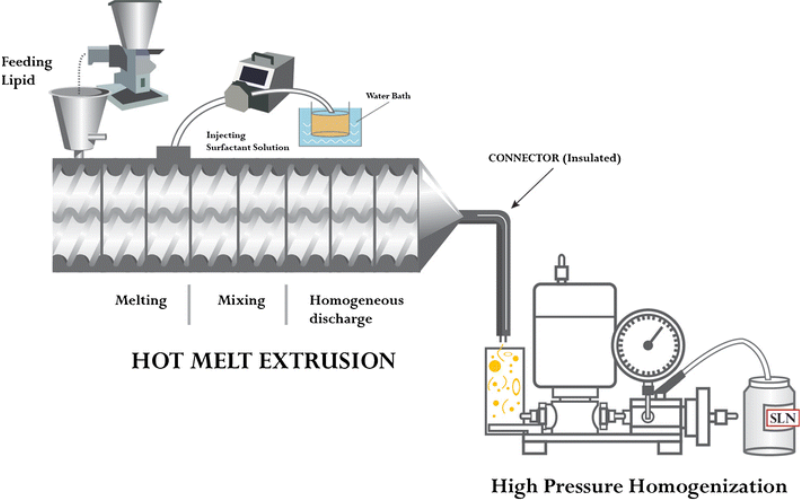
Figure 9. Schematic representation of continuous SLN synthesis using HME-connected HPH. Reproduced with permission from Ref. [54]. Copyright 2014, Elsevier.